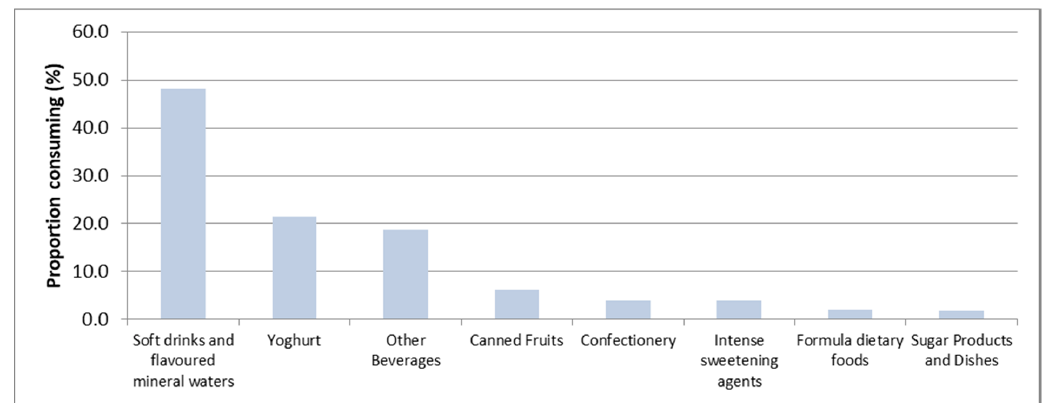
Figure 1. Dietary sources of non-nutritive sweeteners (NNS) among children NNS consumers.